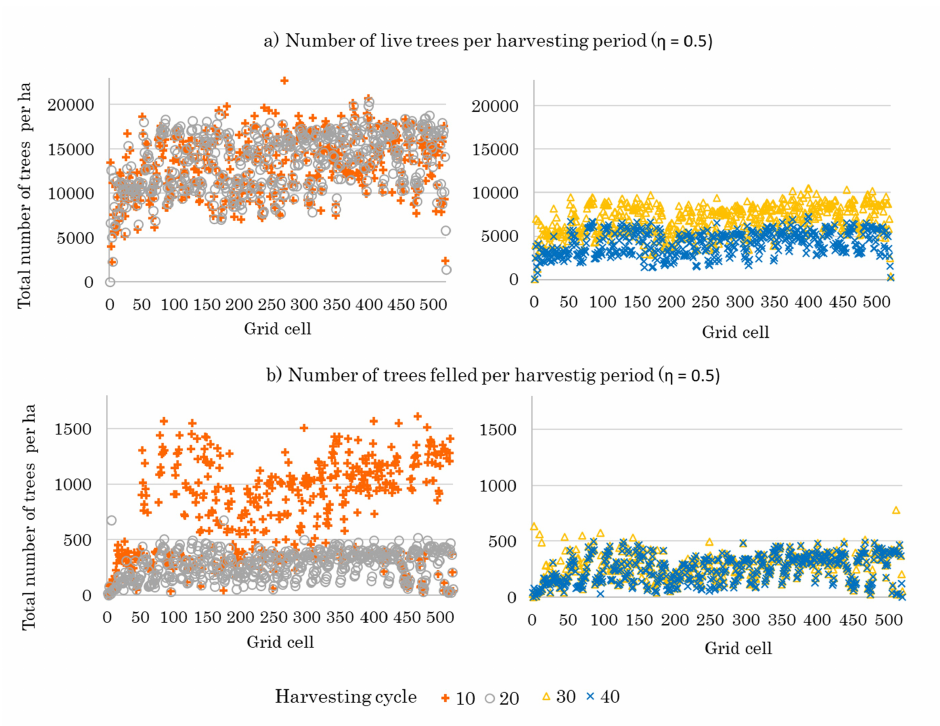
Figure 3. ( a ) Tree stock and ( b ) number of trees felled by cell grid and harvesting period (Results for the joint timber and water (TW) optimization scenario, a discount rate of 4% and a maximum harvesting rate ( η ) of